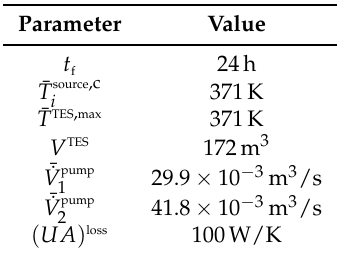
Table 3. Parameter values used in case